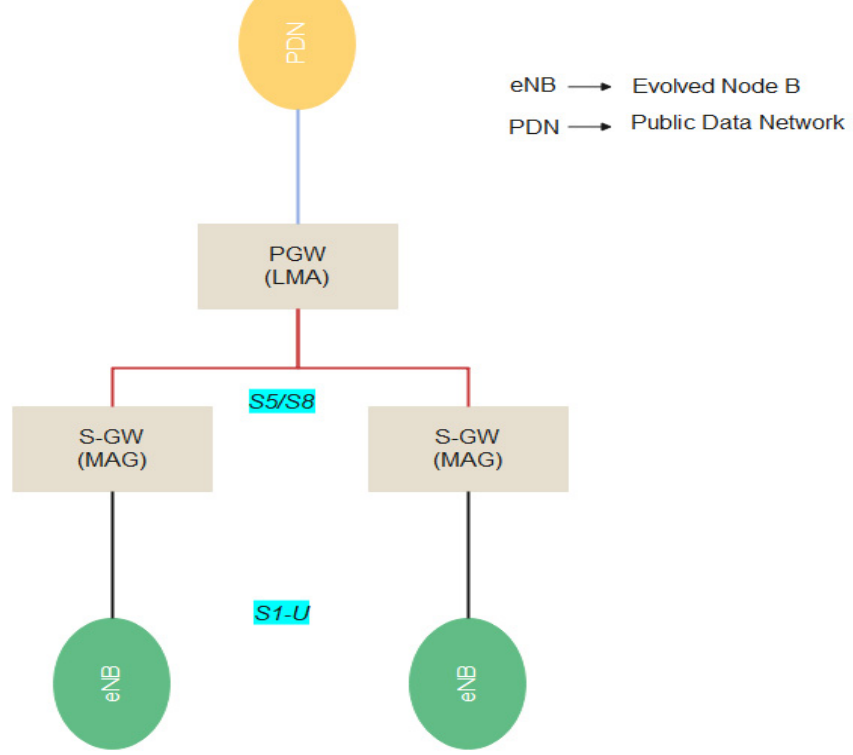
Figure 5. PMIPv6 in the 3GPP EPC system.